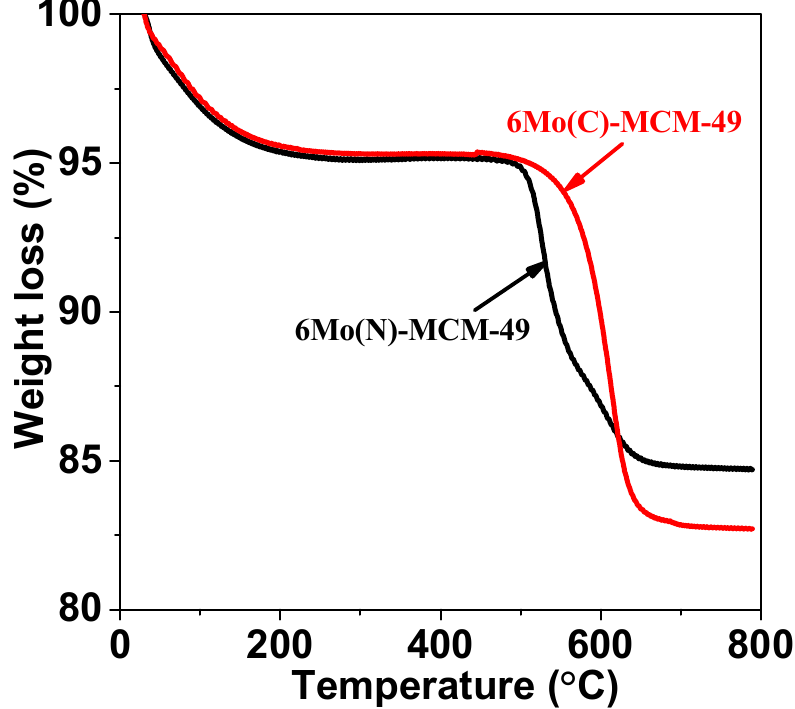
Figure 13. Thermogravimetric analysis of 6Mo(C)-HMCM-49 and 6Mo(N)-HMCM-49 after reacting for 580 min. The catalysts after reaction were analyzed by TGA.